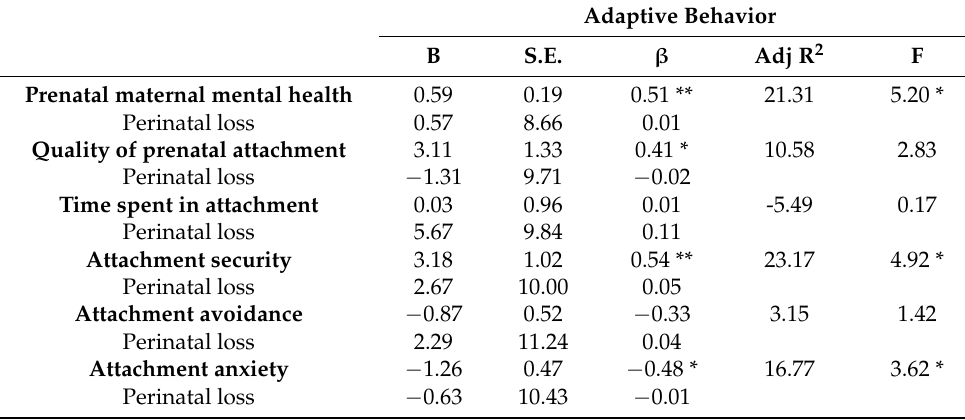
Table 4. Multiple multivariate linear regression models with Bayley-III adaptive behavior as outcome variable and perinatal loss as control variable. Adaptive Behavior B S.E. β Adj R 2